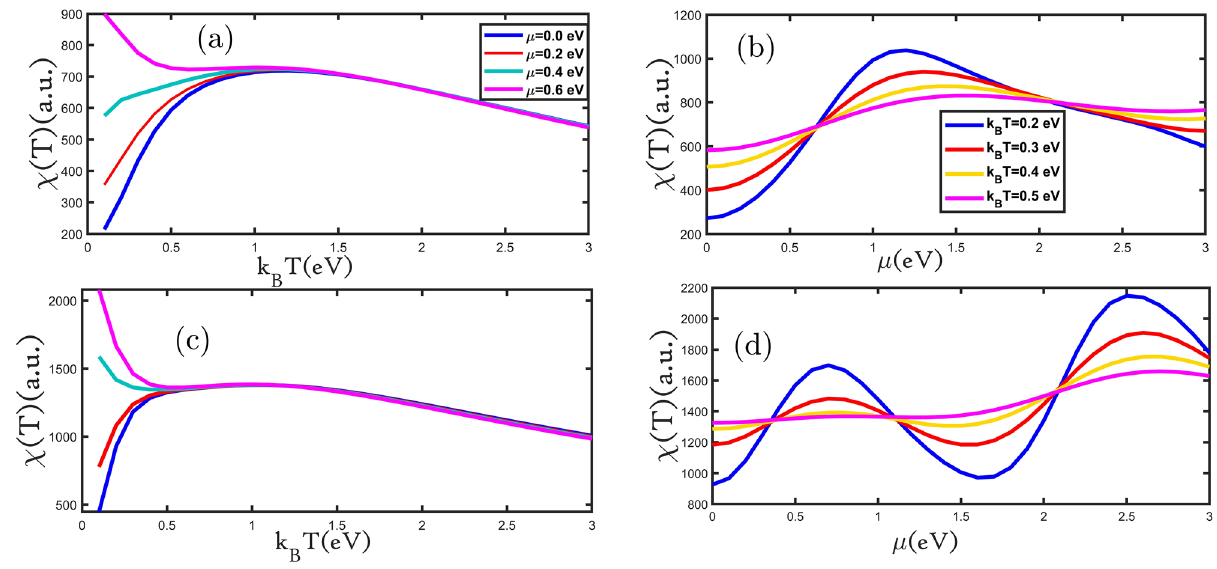
Figure 7. ( a – d ) the magnetic susceptibility as a function of the temperature (electron doping) for planar and buckled silicene monolayers in the presence of different electron doping (temperatures),